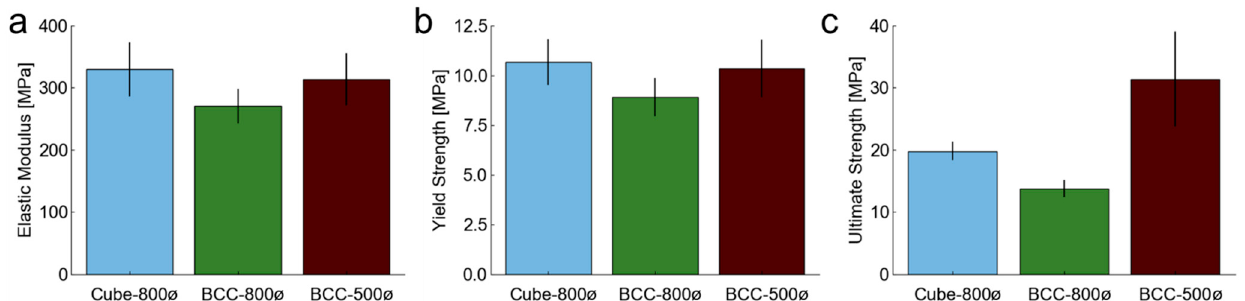
Figure 11. Mean mechanical property measurements for each lattice design with standard deviation bars aggregated from thirty samples for ( a ) elastic modulus E m , ( b ) yield strength Y s , and ( c ) ultimate strength U s .